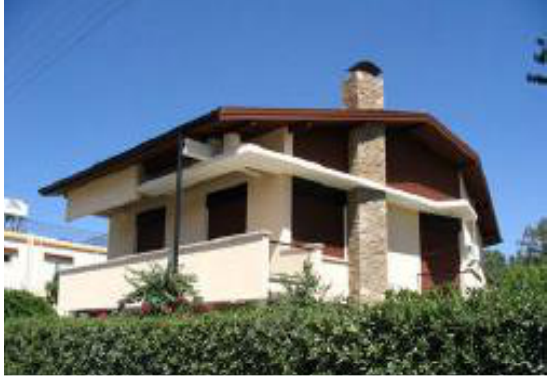
Figure 27. Ferdi Macit House MACIT FERDI HOUSE, NICOSIA 1961 (D.Celik,without date).